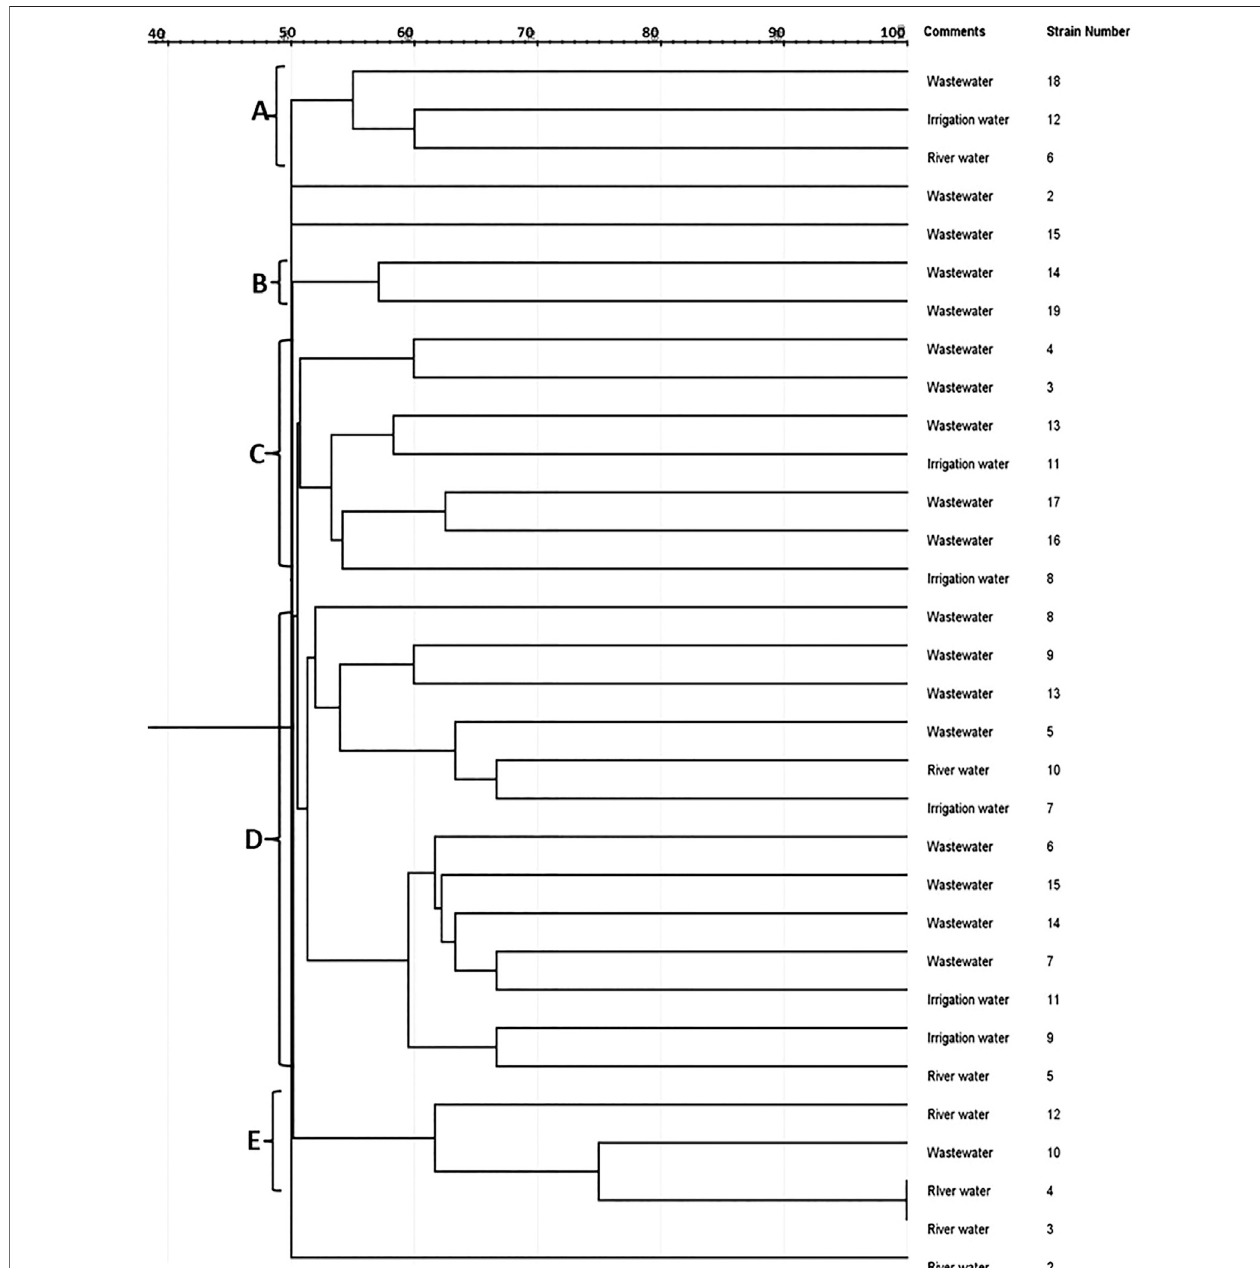
FIGURE 2 | A neighbor-joining dendrogram of ERIC-PCR fi ngerprints of Listeria monocytogenes strains indicating similarities between clustered isolates and their sources.